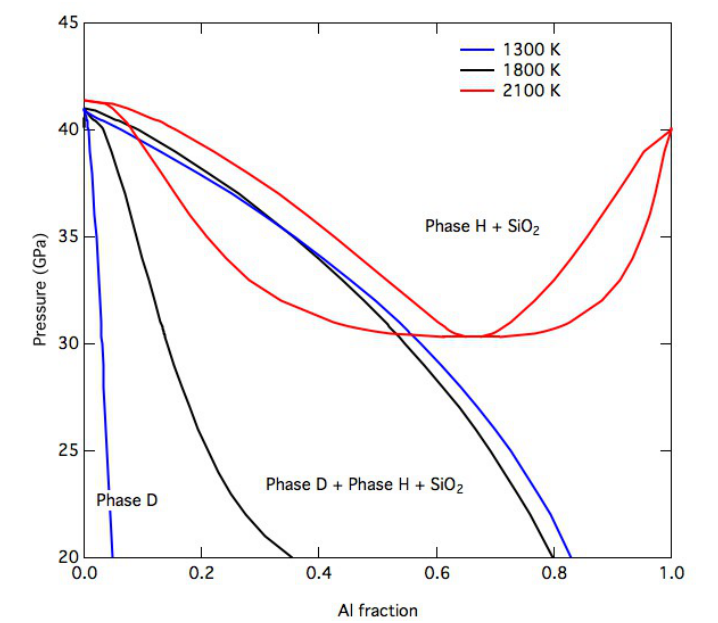
Figure 7. Equilibria between phase D and phase H + SiO 2 as a function of pressure and aluminum content at 1300 K (blue), 1800 K (black), and 2100 K